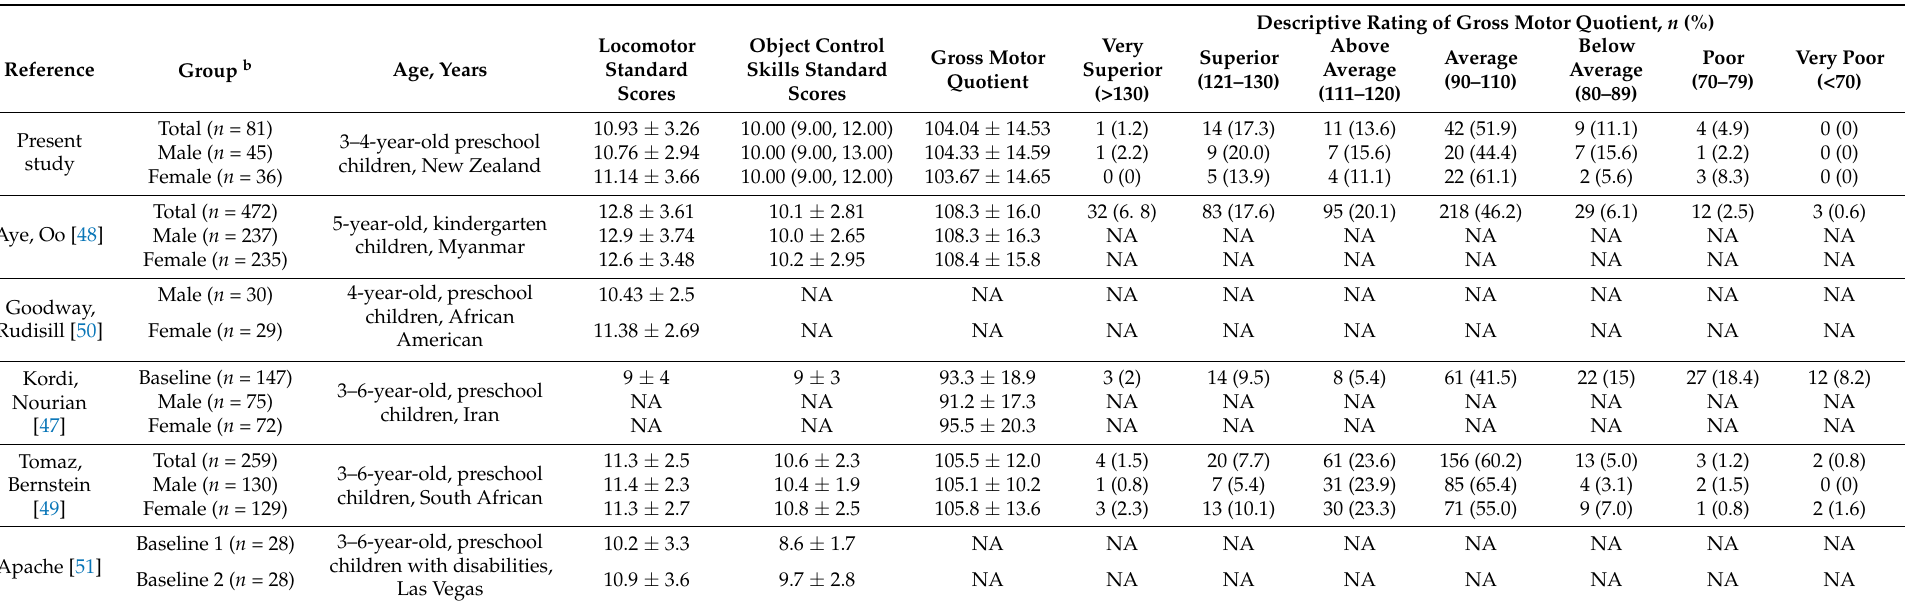
Table 4. Comparison of Test of Gross Motor Development, 2nd Edition (TGMD-2) scores a